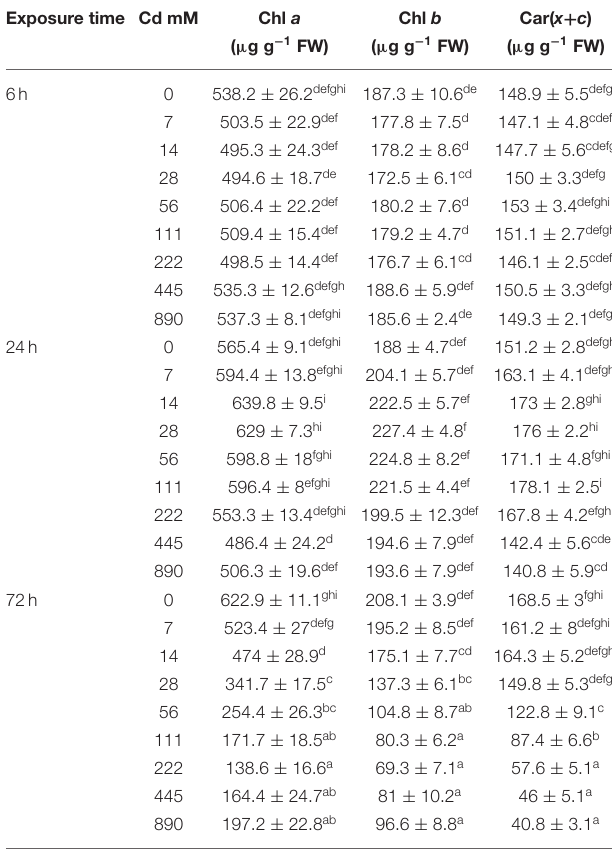
TABLE 2 | Analysis of the differences between categories (Cd × time) with FA as a